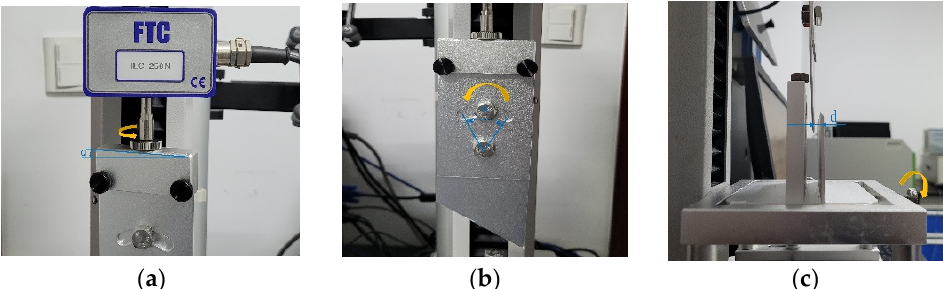
Figure 2. Cutting and clamping device of the experiment test equipment. ( a ) Adjusting device of the oblique angle. ( b ) Adjusting device of the sliding angle. ( c ) Adjusting device of the cutting gap.